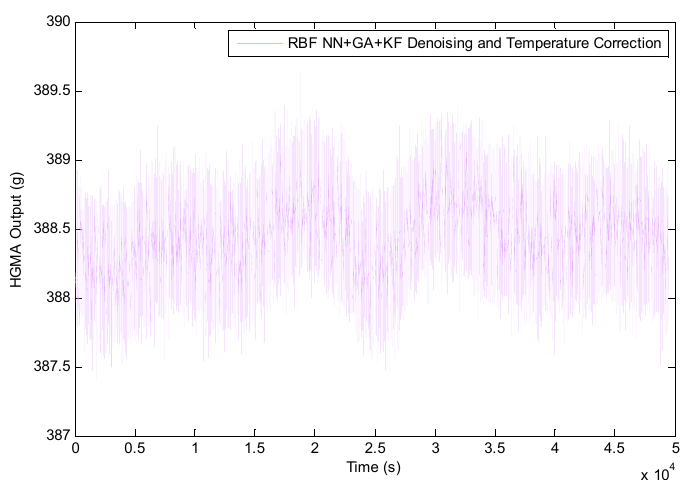
Figure 12. The compensation results of accelerometer based on three methods.